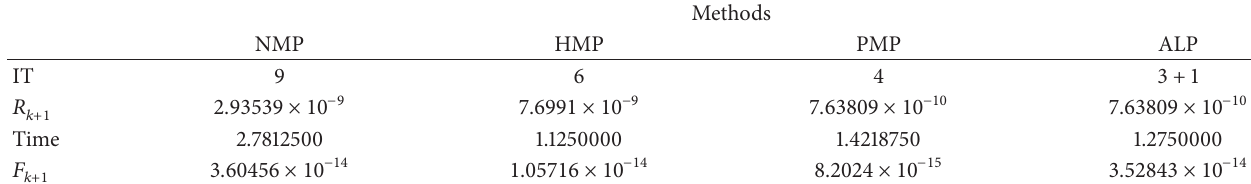
Table 1: Results of comparisons in Example 1 with 𝑈 0 = 𝐴 for polar